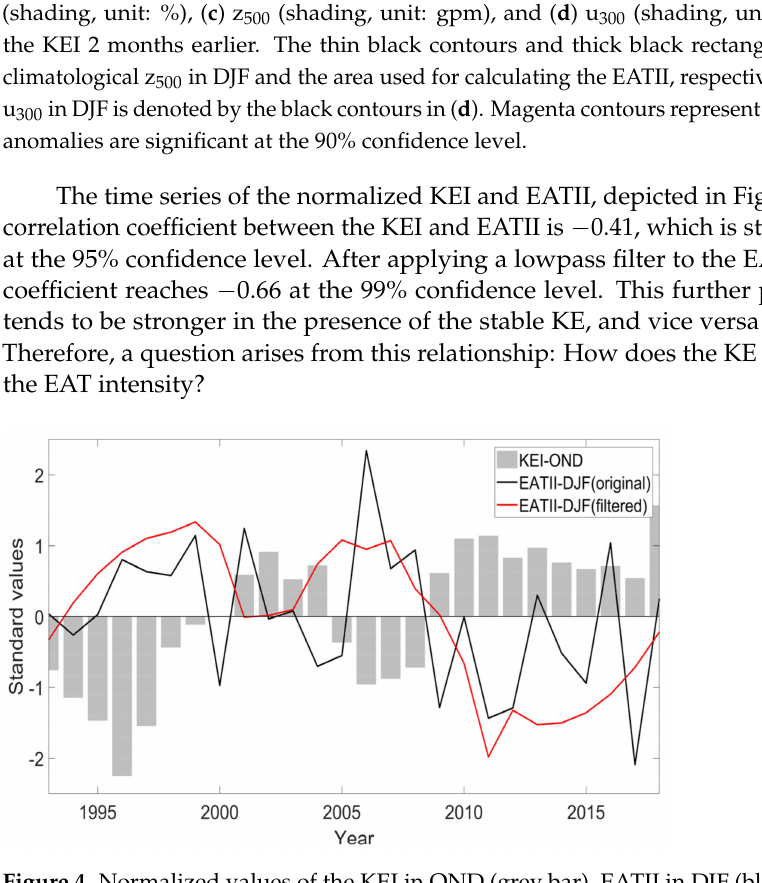
Figure 4. Normalized values of the KEI in OND (grey bar), EATII in DJF (black line), and lowpass EATII in DJF (red line). The lowpass EATII is calculated by applying a Savitzky–Golay filter with a window length of 11 years and a degree 2 polynomial to the EATII, to extract the EAT variation signal with the same frequency as the